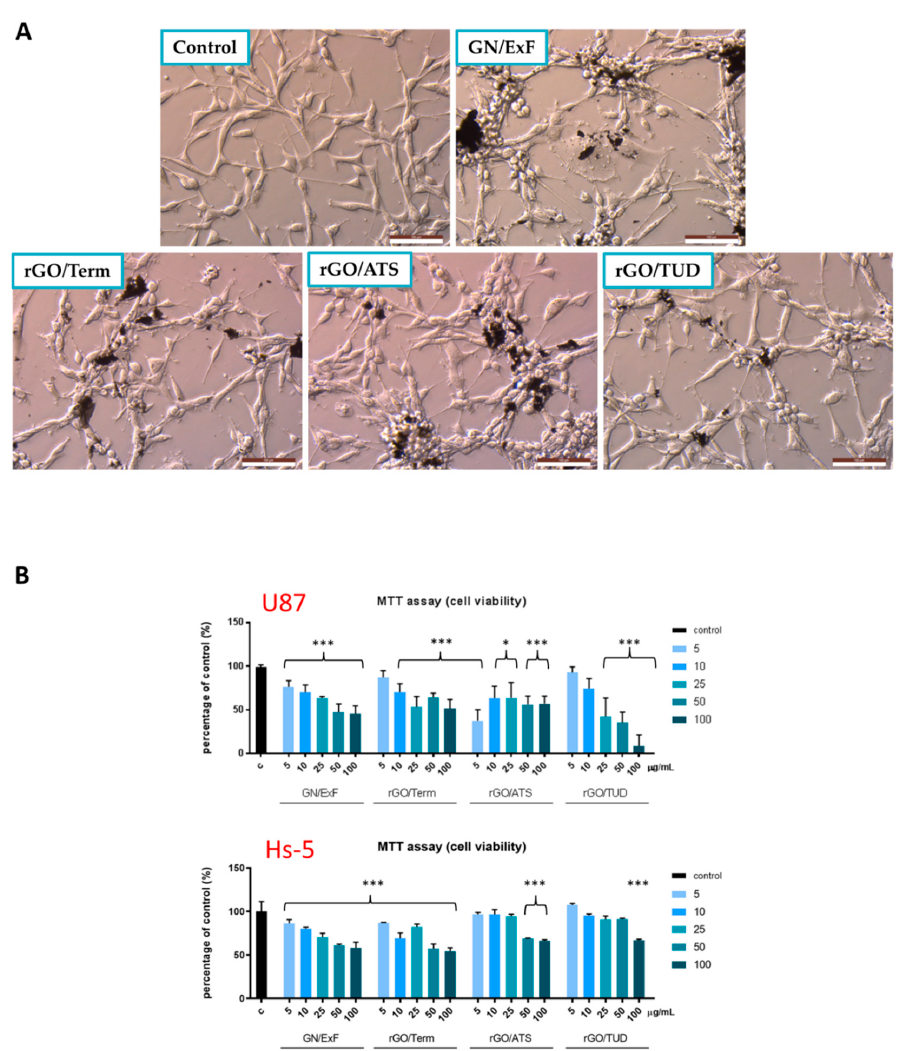
Figure 3. Morphology and cell viability of untreated U87 cells, and those treated with GN and rGO flakes, as evaluated by optical microscopy and viability assays. ( A ) The images show untreated U87 cells and those treated with GN and rGO flakes. Control cells were not treated with graphene flakes. Scale bar: 100 μ m. Cell viability was determined using the ( B ) MTT assay. U87 and Hs-5 cells were exposed to GN and rGO flakes at concentrations of 5, 10, 25, 50, and 100 μ g/mL for 24 h. Values are expressed as mean ± standard deviation. Statistical significance between the control and treated cells is indicated by an asterisk and was assessed using Bonferroni’s multiple comparison test. Differences with p -value < 0.05 were considered significant. One asterisk (*) p -value < 0.01, three asterisks (***) all with p -value < 0.001. Abbreviations: rGO, reduced graphene oxide; GN, graphene; MTT, 3-(4,5- dimethylthiazol-2-yl)-2,5-diphenyltetrazolium bromide. In the examined samples, the number of cells in the field of view was kept constant (Figure 3A).